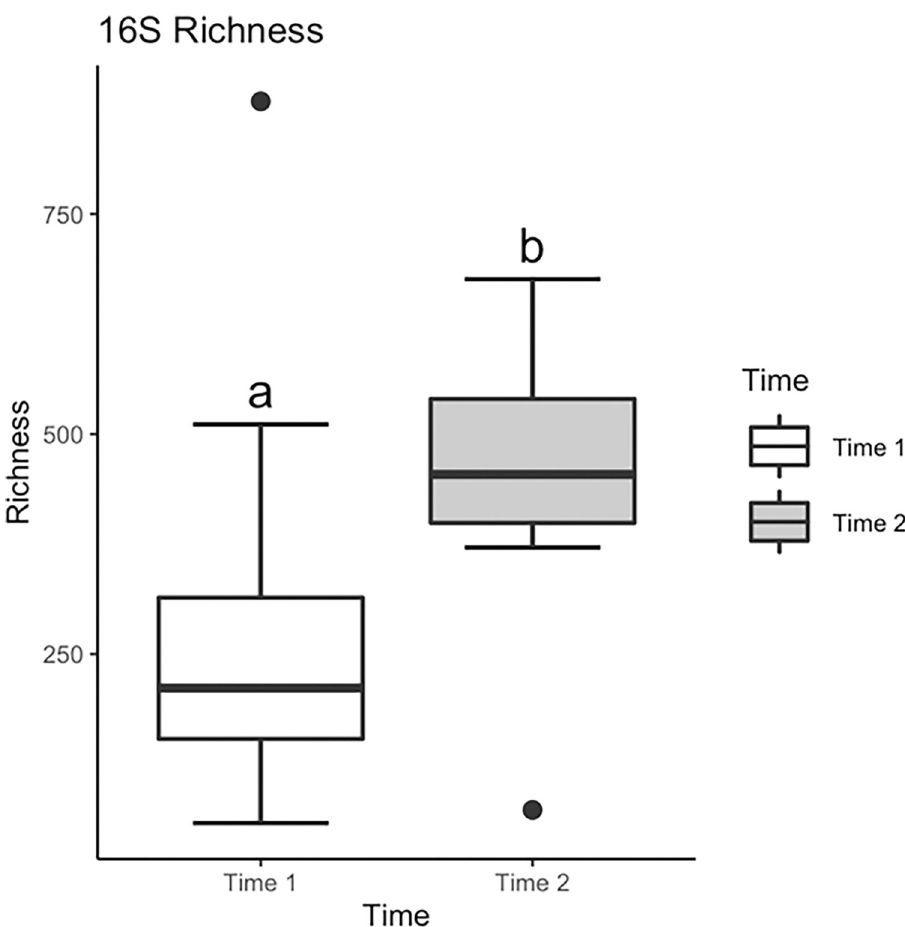
Fig 1. Bacterial (16S) lake sturgeon egg surface community richness (means ± SE) for samples across aquatic insect treatments collected during time 1 and 2 (1 da and 4 da post fertilization, respectively).